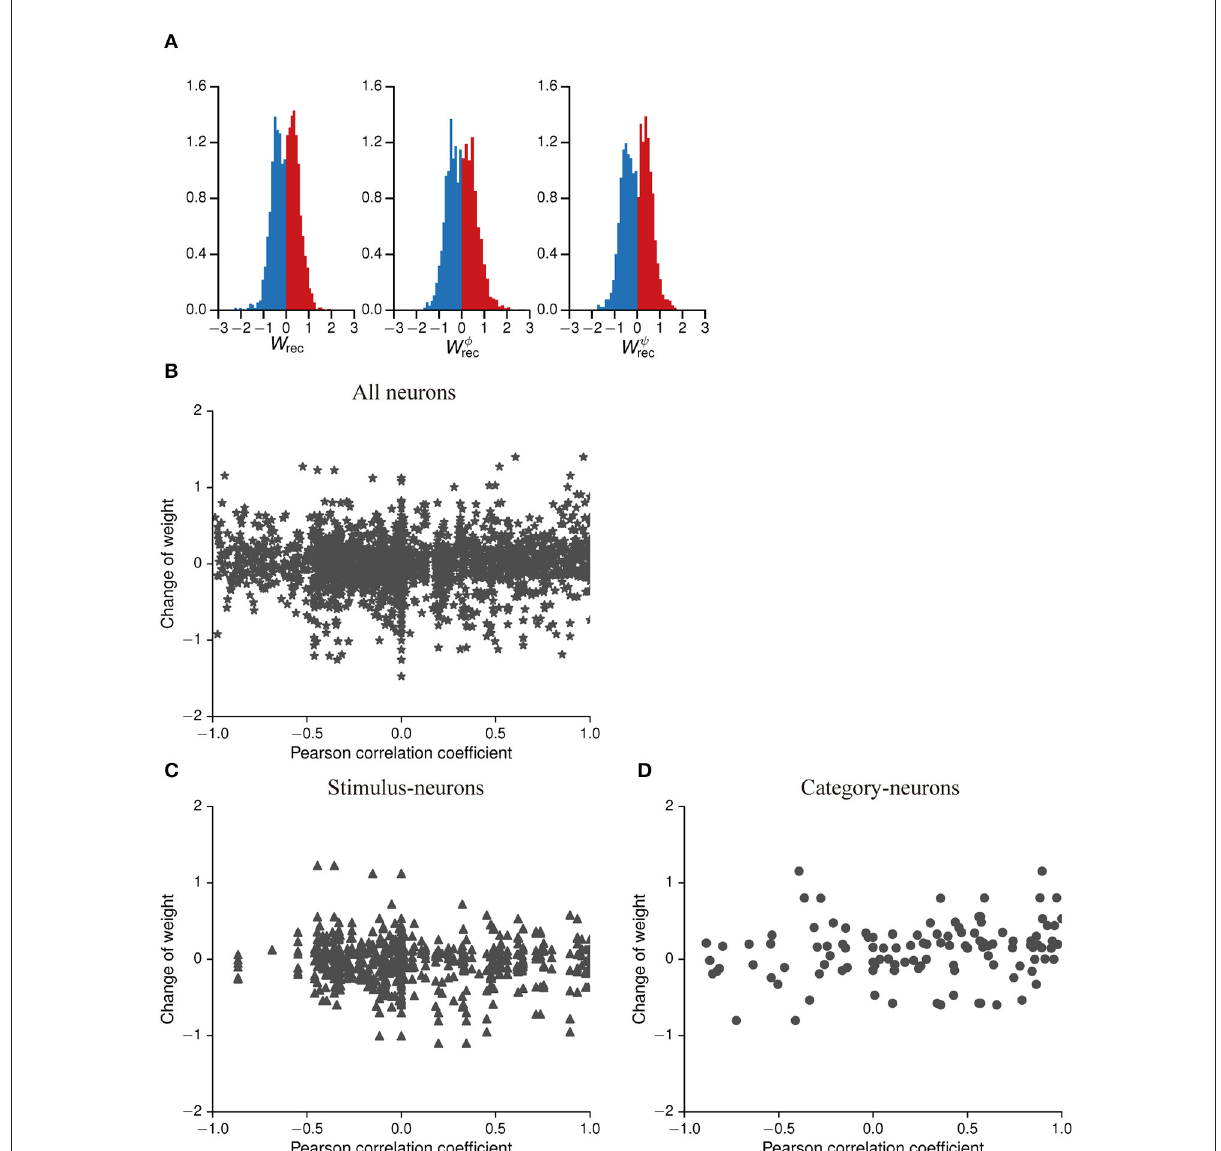
FIGURE8 Distributions of weights in the policy network and the correlation analysis between activity-patterns and weight changes. (A) Frequency distribution histogram about the connection weights of neurons in the IIL of the policy network. The dark red bars denote excitatory weights, which are positive, and the dark blue bars denote inhibitory weights, which are negative. Left panel: weights of among neurons in the recurrent network; middle panel: weights of the update gates; right panel: weights of the reset gates. (B–D) show correlation analysis between the activity-pattern similarity of each pair of neurons (Pearson correlation coefficient) and their weight change. (B) All pairs of neurons that have connection in the IIL. (C) Pairs of connected neurons are selected only from stimulus-neurons. (D) Pairs of connected neurons are selected only from